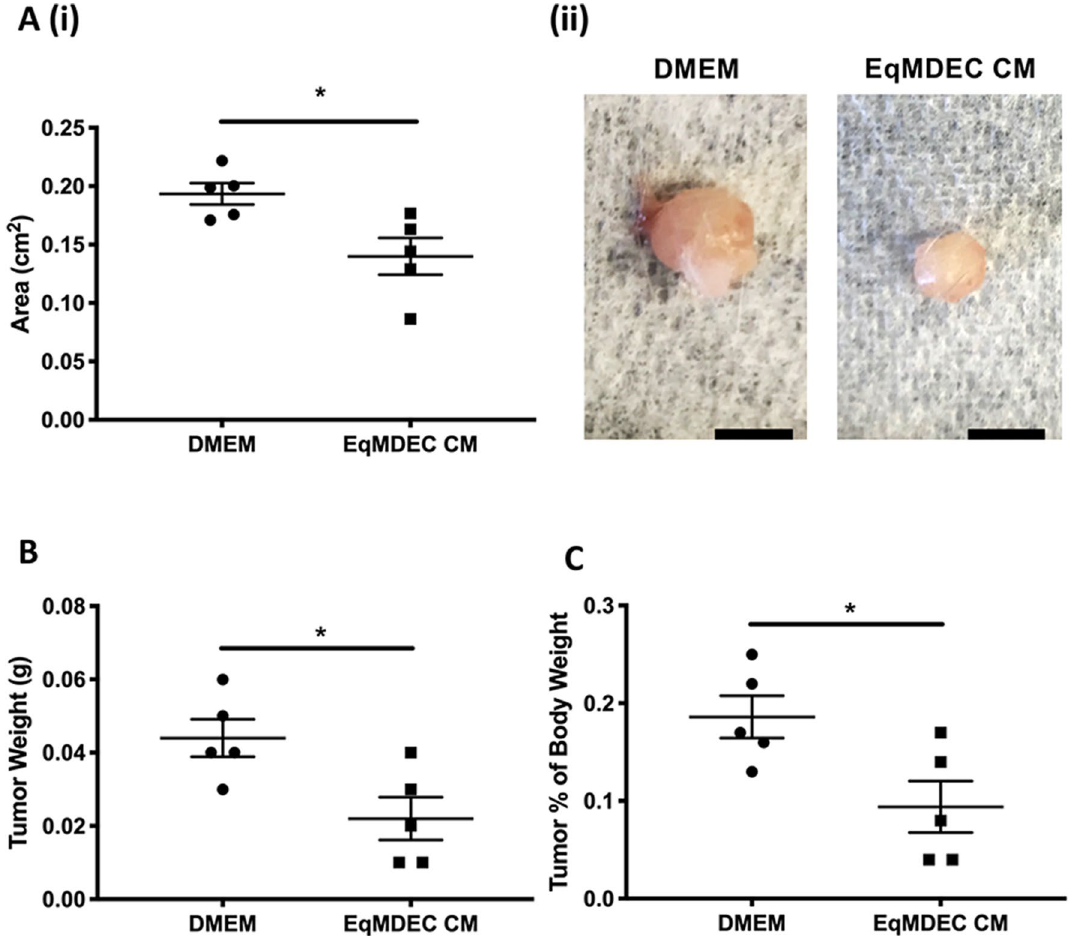
Figure 2. The secretome of EqMDEC reduces tumorigenicity in vivo. NSG mice were injected orthotopically with 3 × 10 6 MDA-MB-231 cells in Matrigel. Two weeks later, mice were intratumorally injected with DMEM (control) or EqMDEC conditioned medium (CM) daily for two weeks. ( A ) Quantification of tumor area ( i ) and representative images of tumors removed from mice treated with either DMEM (control) or EqMDEC CM ( ii ).